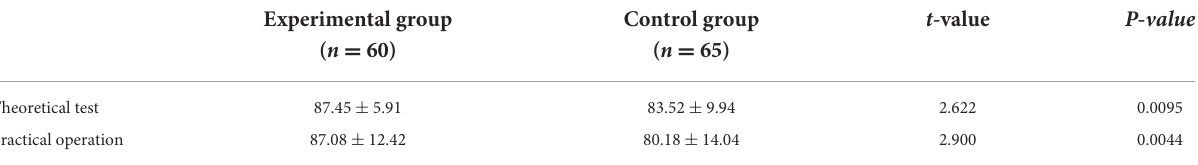
TABLE 2 Comparison of theoretical and practical test scores between the two student